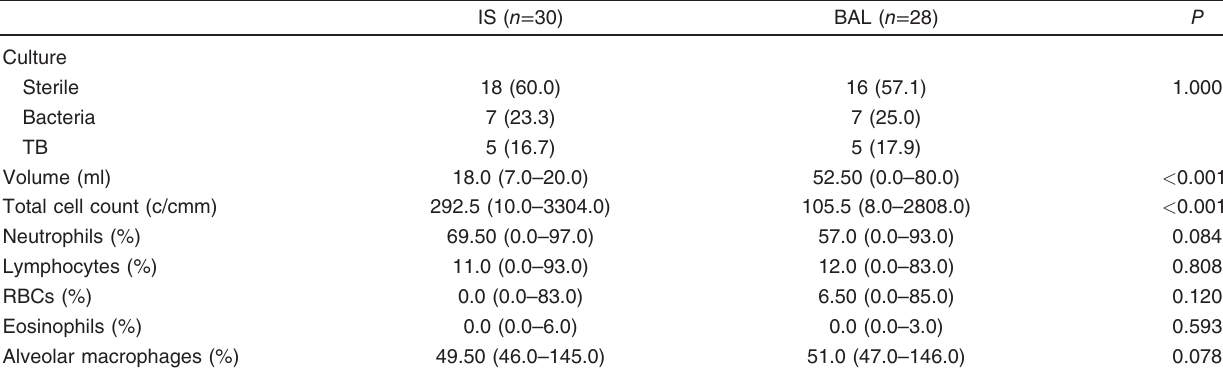
Table 2 Comparison between the two groups according to different parameters